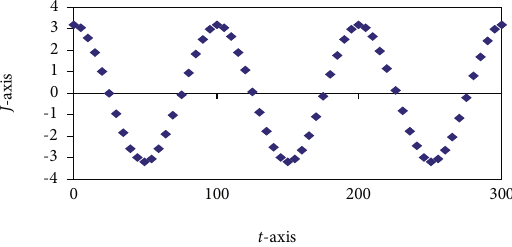
Figure 4: The numerical solution J against the time t